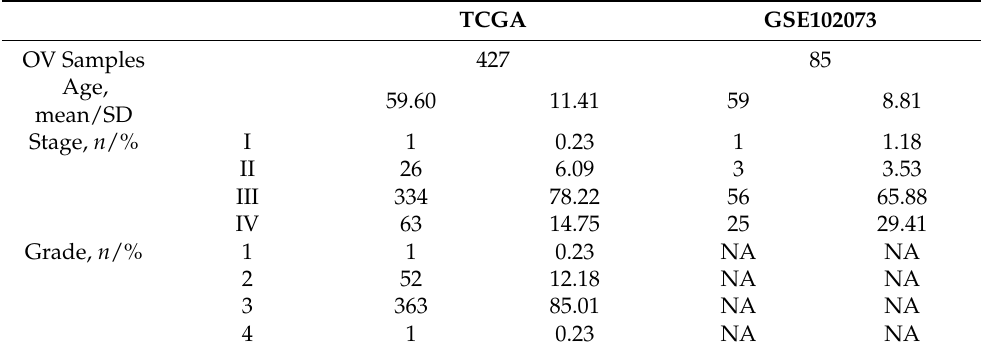
Table 1. Clinical data of OV